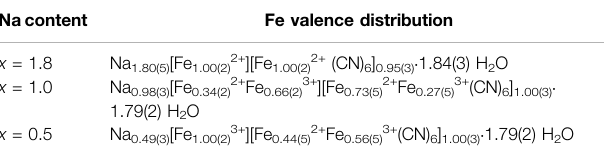
TABLE3| ResultfortheFevalencedistributionasmeasuredat90 Kinthestudied samples from the analysis given in the text. Nacontent Fe valence distribution x = 1.8